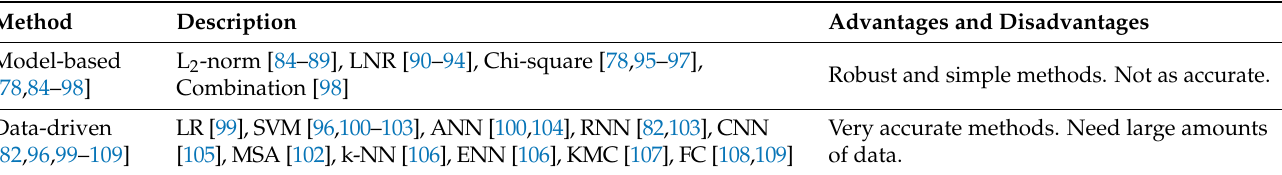
Table 4. Bad data detection methods